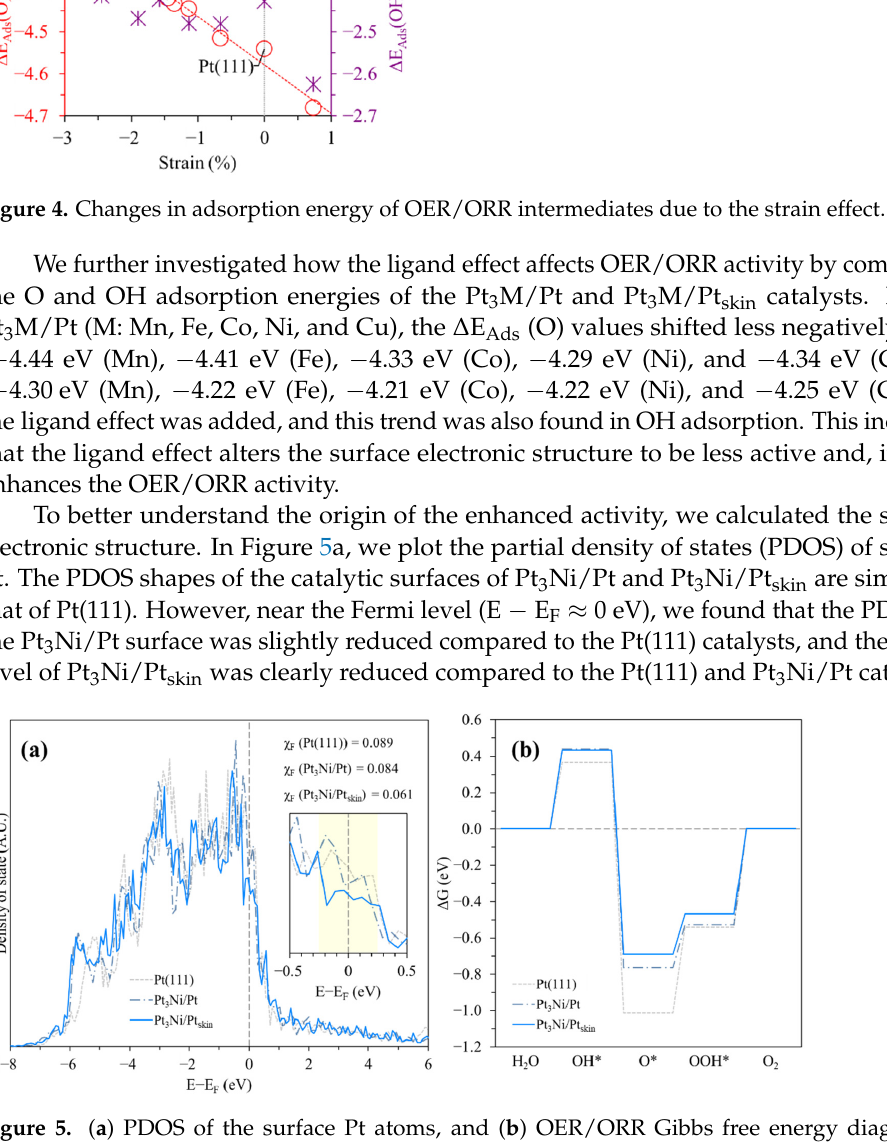
Figure 5. ( a ) PDOS of the surface Pt atoms, and ( b ) OER/ORR Gibbs free energy diagram at equi- librium potential for Pt(111), Pt 3 Ni/Pt, and Pt 3 Ni/Pt skin catalysts. An asterisk (*) denotes the adsorp- tion state.